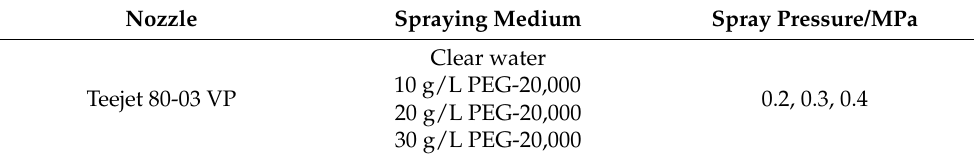
Table 1. Spray Table 1. Spray parameters.